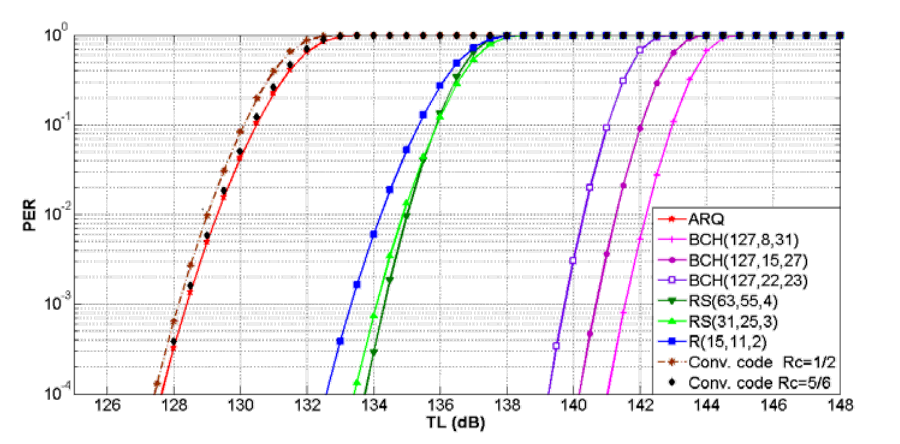
Figure 14. PER as a function of transmission loss for deep